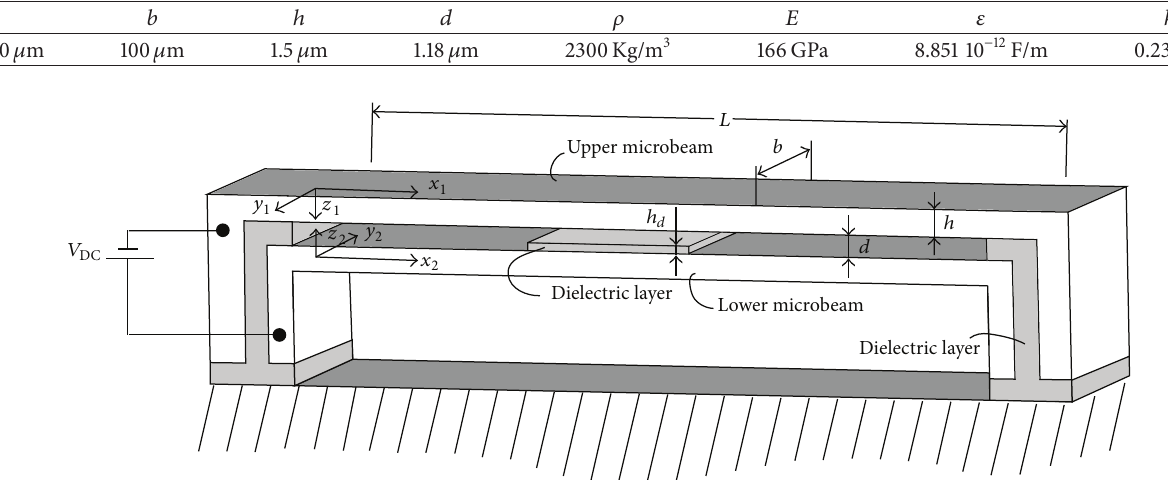
Table 1: Geometric and physical parameters of the beam.